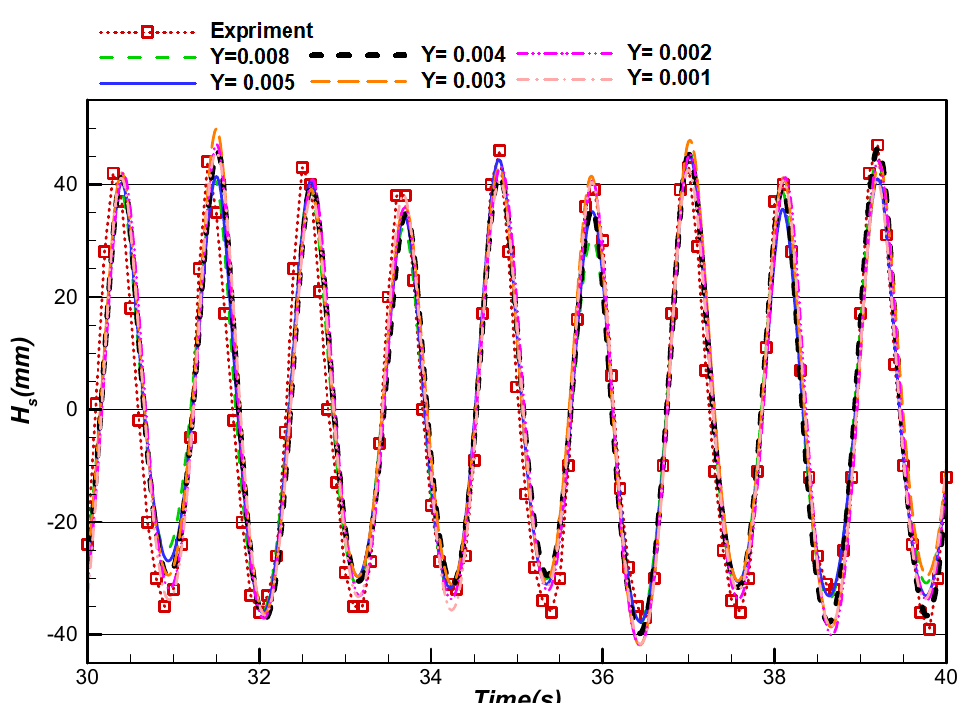
Figure 15. Validation and mesh independence of the simulation.